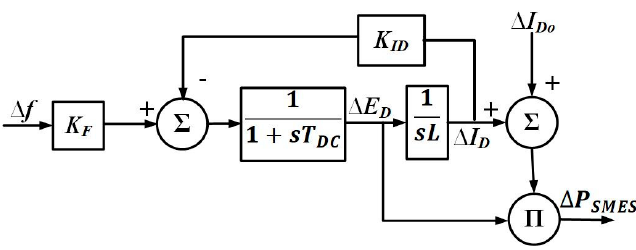
Figure 6. SMES subsystem block.